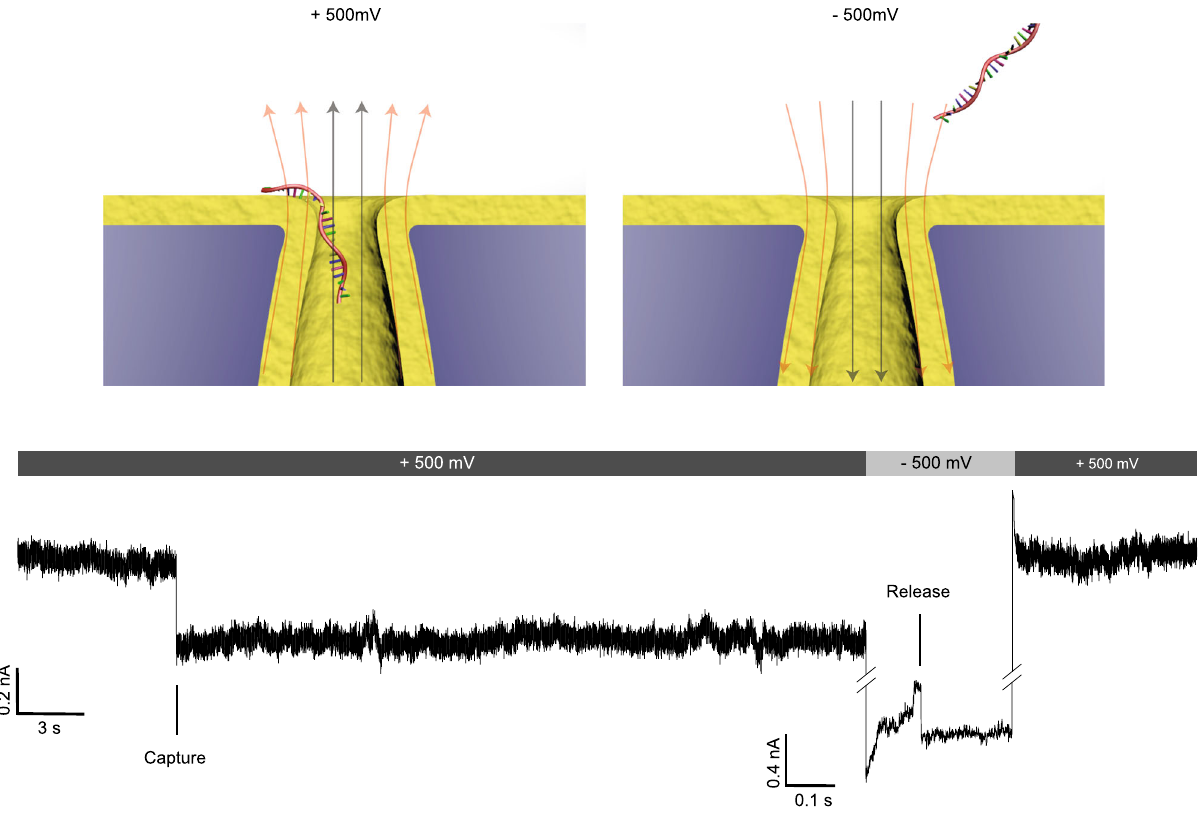
Fig. 8 Reversibility of the molecular pinning. Electrical recording of 22 nt ssDNA pinning at the pore edge of a bullet-shaped Al 2 O 3 -coated (thickness, 3 nm) nanopores (diameter, 10 nm) with a half cone angles of 20 ± 3° under applied voltage of + 500 mV (energy barrier, 12.7 kT ) and ssDNA escaping from the nanopore after the electrostatic trapping effect is switched off by reversing the polarity of applied voltage to − 500